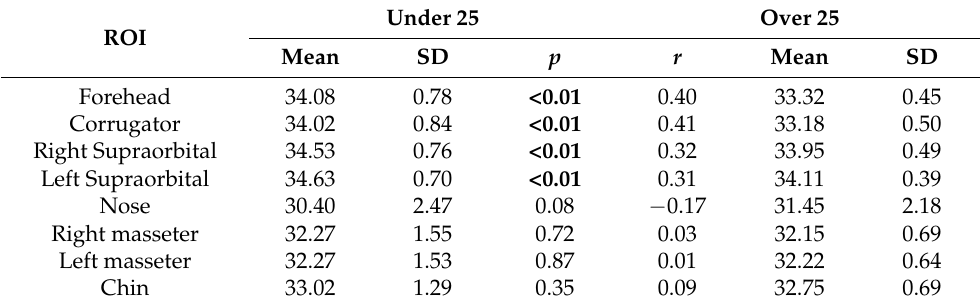
Table 4. Age comparison table.